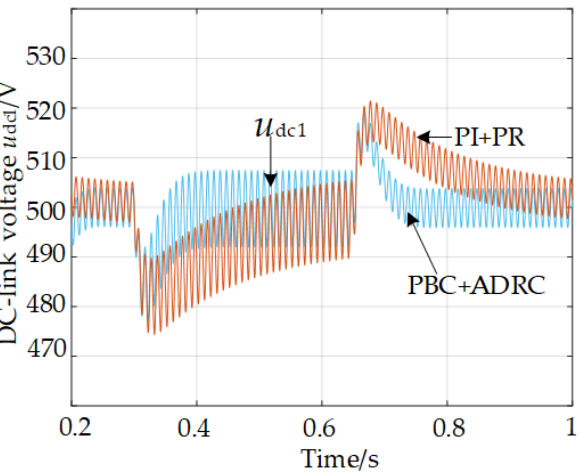
Figure 10. DC-link voltage responses under load disturbance under different control